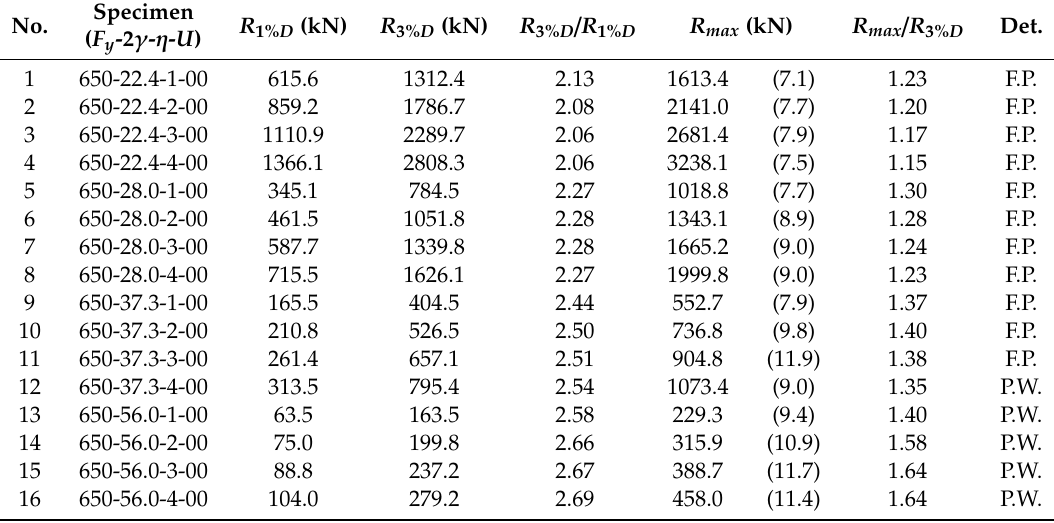
Figure 12. Load–indentation curves of S1100 ( F y = 1100 MPa): ( a ) 2 γ of 22.4 and 37.3; ( b ) 2 γ of 28.0 and 56.0. Table 9. Parametric analysis results of HSA800 ( F y = 650 MPa).